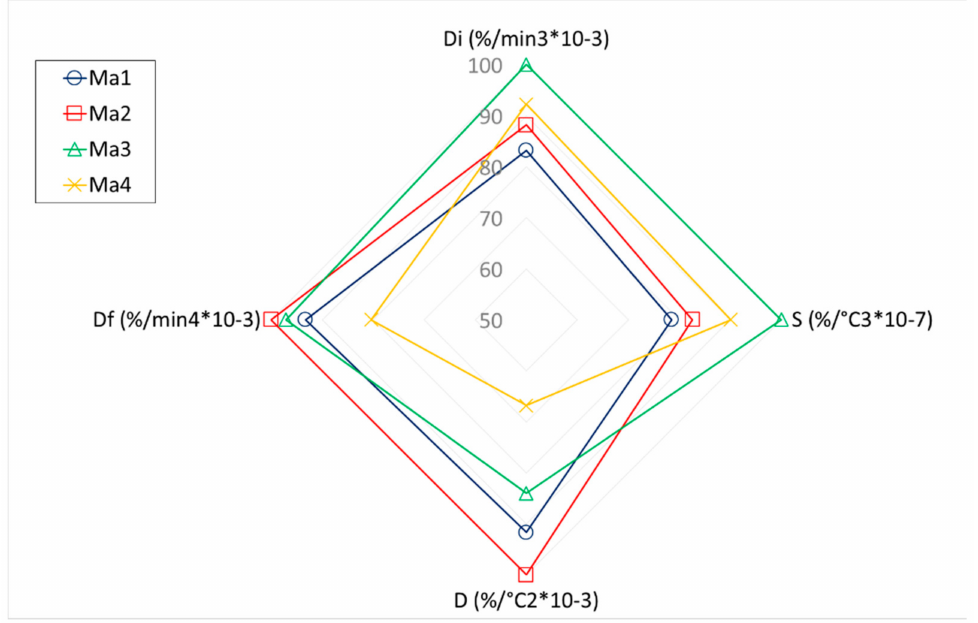
Figure 6. Combustion